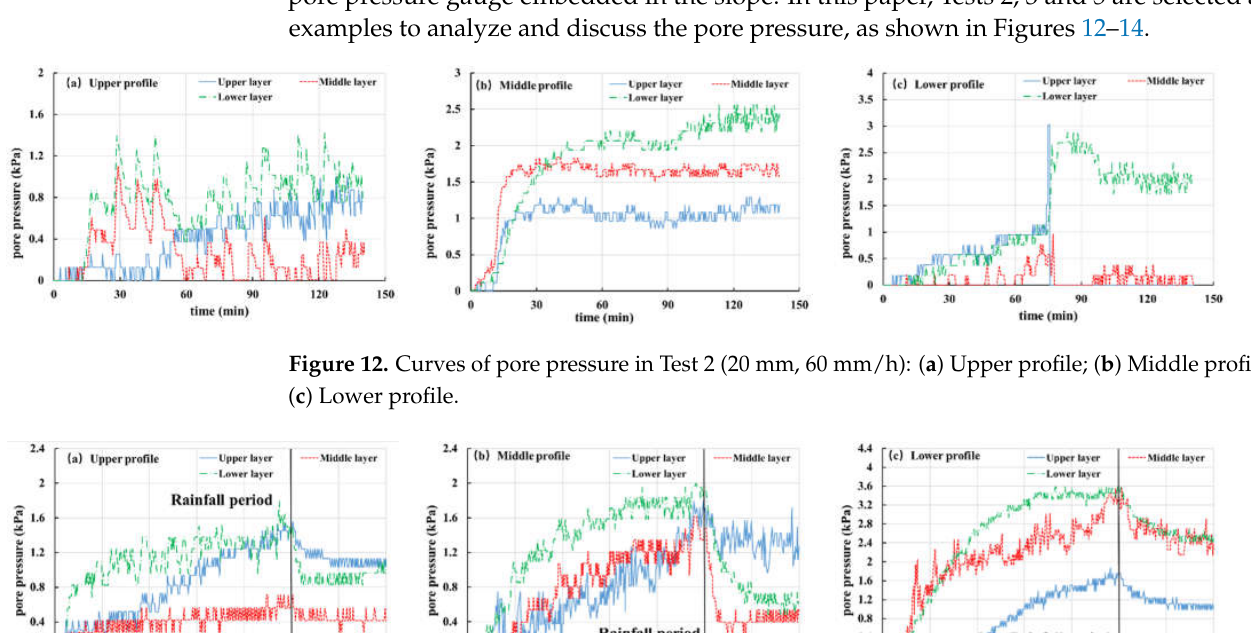
Figure 14. Curves of pore pressure in Test 5 (-, 30 mm/h): ( a ) upper profile; ( b ) middle profile; ( c ) lower profile. Figure 12 shows the pore pressure variation curve of Test 2 (the thickness of the weak layer is 20 cm and the rainfall intensity is 60 mm/h). The buried depth of pore pressure gauges in the upper, middle and lower layers is 10 cm, 30 cm and 50 cm, respectively. From the figure, it can be seen that the pore pressure of each site is rising, starting from 15 min, and rainwater gradually infiltrates into the slope. The pore pressure in the middle section (Figure 12a) is particularly obvious. The pore pressure remains stable until about 45 min, indicating that the interior of the slope reaches a saturated state. A significant fluctuation in pore pressure was observed in about 80 min (Figure 12b). Combining with the previous slope displacement monitoring results (Figure 11b) and experimental phe- nomena, it is found that the slope slides at this time, leading to the upper pore pressure gauge sliding along with the soil. Figures 13 and 14 show the pore pressure curves of slopes with a 10 cm-thick weak layer and slope without a weak layer under rainfall intensity of 30 mm/h, respectively. The variation in pore pressure at each point of the two groups is the same, i.e., during the rainfall period (the first 300 min), pore pressure gradually increases with rainfall infiltra- tion, and the increase in pore pressure increases from the top section to the bottom section in turn. When rainfall stops, the curve shows that pore pressure is also gradually dissipat- ing. It should be pointed out that the pore pressure value in the middle layer of Figure 13a is small and has no obvious change. This happens because the pore pressure gauge is located in the differentiated basalt soil and its permeability is strong. A flow passage is formed around the buried position of the pore pressure gauge, which is conducive to the rapid discharge of groundwater, resulting in little change in pore pressure during the whole process. 5.2. Change in Earth Pressure in Slopes In the present work, the overlying load of strain gauge is measured by an earth pres- sure gauge, which includes pore water pressure and contact pressure of soil particles. Corresponding to pore water pressure, Tests 1, 2, 3 and 5 are selected for analysis and discussion of earth pressure, as shown in Figures 15–18.